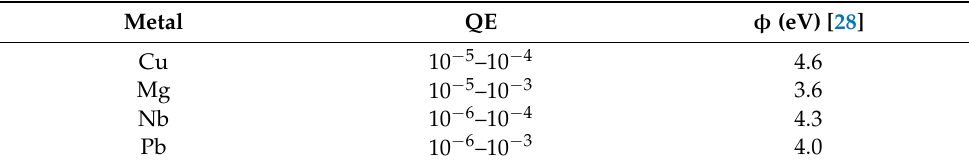
Table 1. Several stable metals with a work function of less than 5 eV considered as photocathodes in electron guns.